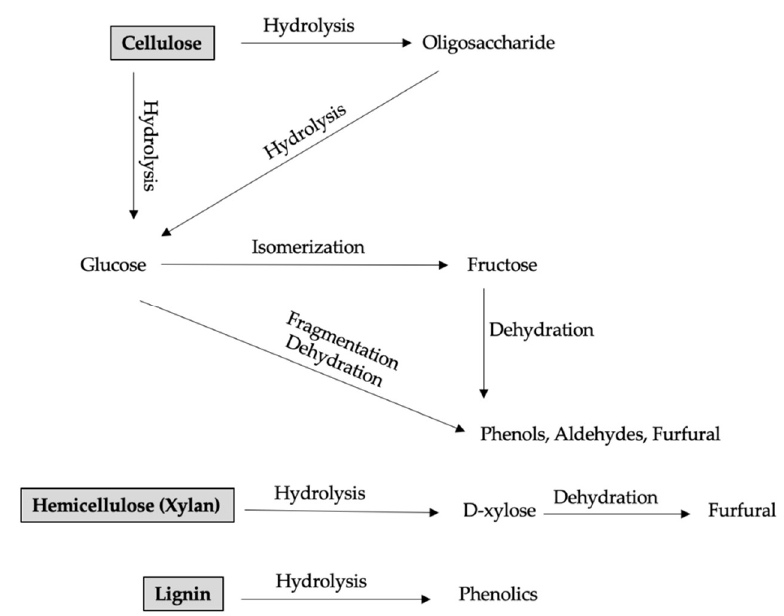
Figure 2. Proposed reaction network for hydrochar production.